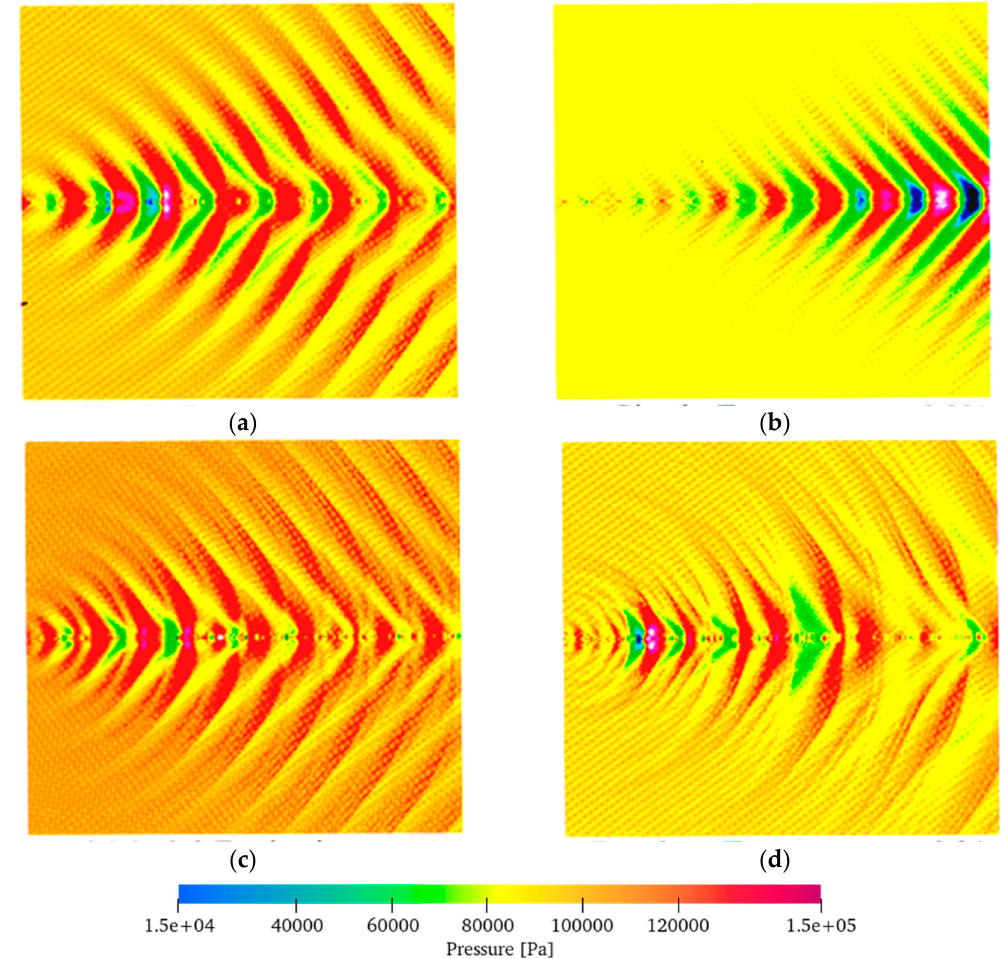
Figure 20. Snapshots of the instantaneous pressure fluctuations in a M = 2.1 round jet for four different cases of inflow excitation with excitation amplitude of (cid:2035) . ( a ) Single frequency (cid:2035) = 0.04 . ( b ) Single frequency (cid:2035) = 0.001 . ( c ) Bi-modal frequency (cid:2035) = 0.04 . ( d ) Random frequency (Ref. [58,71]).